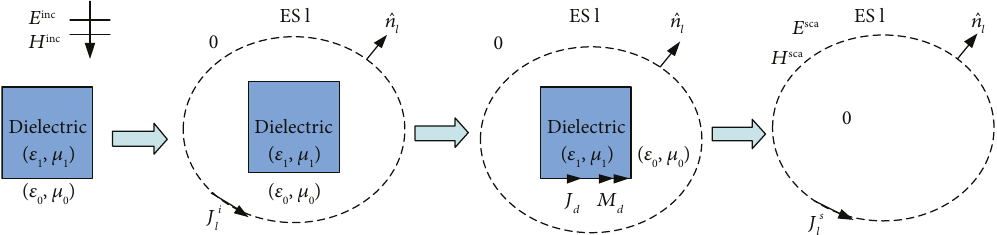
Figure 4: A dielectric object enclosed by an equivalence surface with three steps.